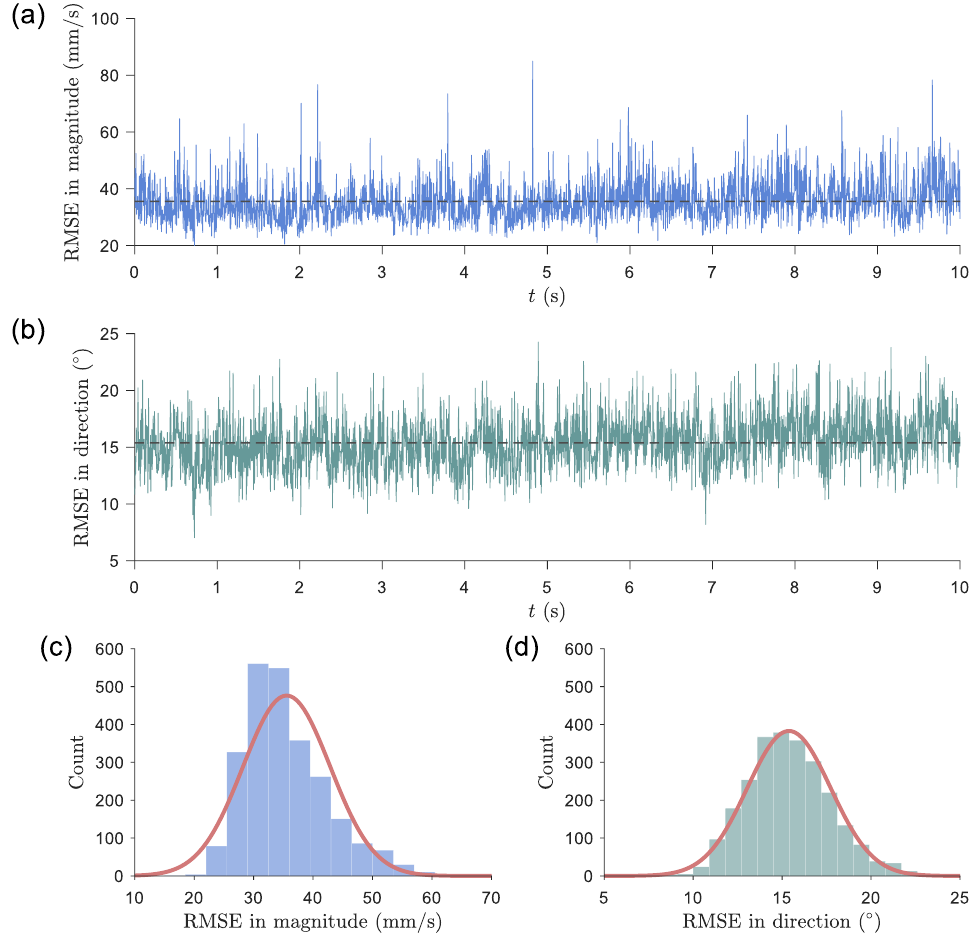
Figure 8. ( a , b ) are the time series of RMSE in magnitude and direction, respectively, for the vectors corresponding to 2nd peak in case PIVB , with dashed line being the mean value in each plot. ( c , d ) are the histogram plots of ( a , b ), respectively, with maroon curves being Gaussian fit.